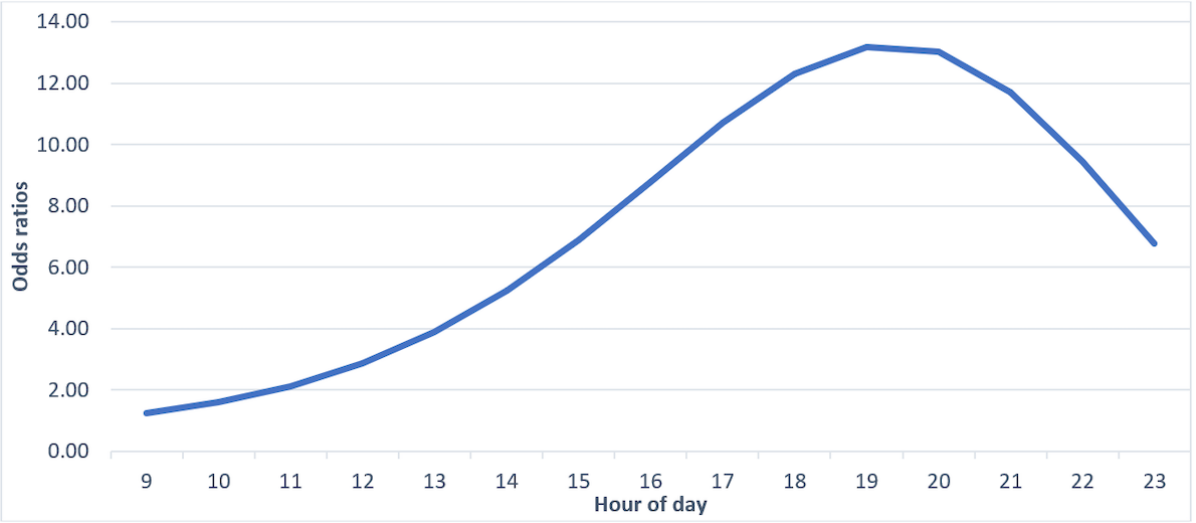
Figure 1. Odds ratios of obtaining average moderate-to-vigorous physical activity before each hour of